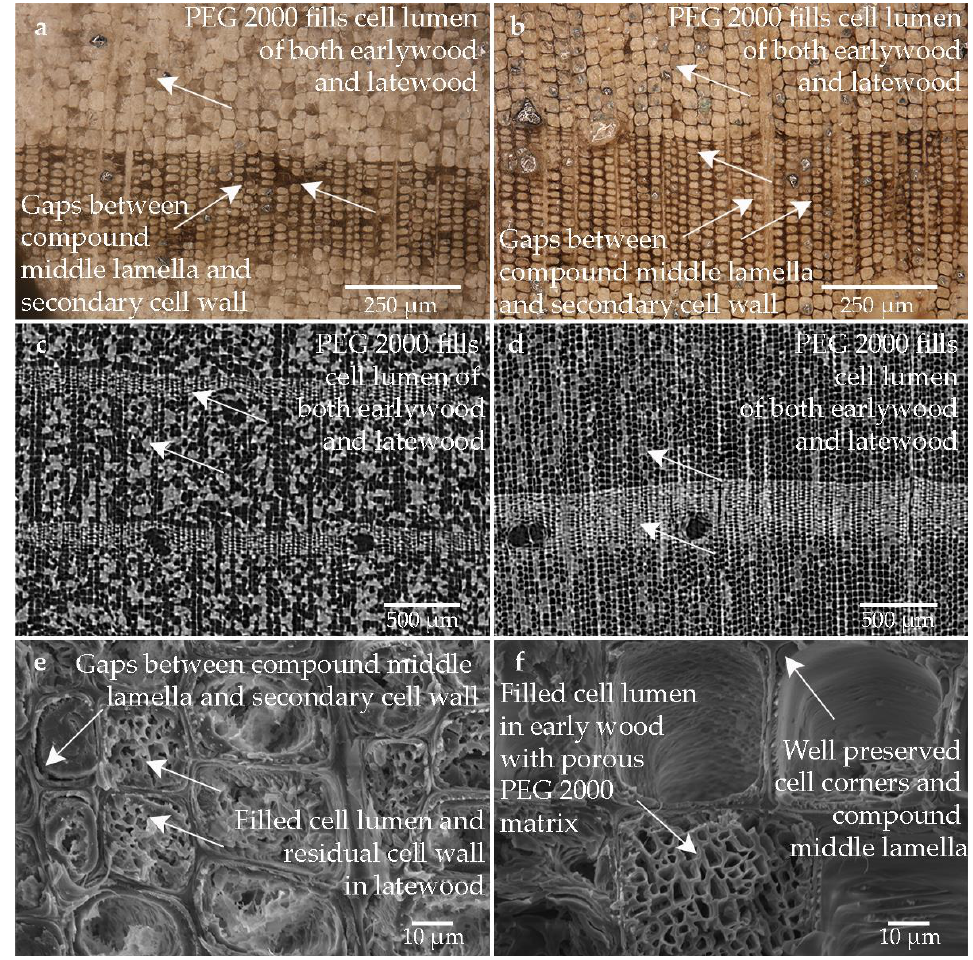
Figure 6. Microscopic wood structure of sample conserved with PEG 2000 and freeze-drying (Pi1- PEG1) ( a ) RLM image from the heavily degraded area; ( b ) RLM image from the low degraded area; ( c ) CT image of the cross section of the heavily degraded sample; ( d ) CT image of the cross section of the low degraded sample; ( e ) SEM image of the latewood tracheids; ( f ) SEM image of the earlywood tracheids in the heavily degraded area.